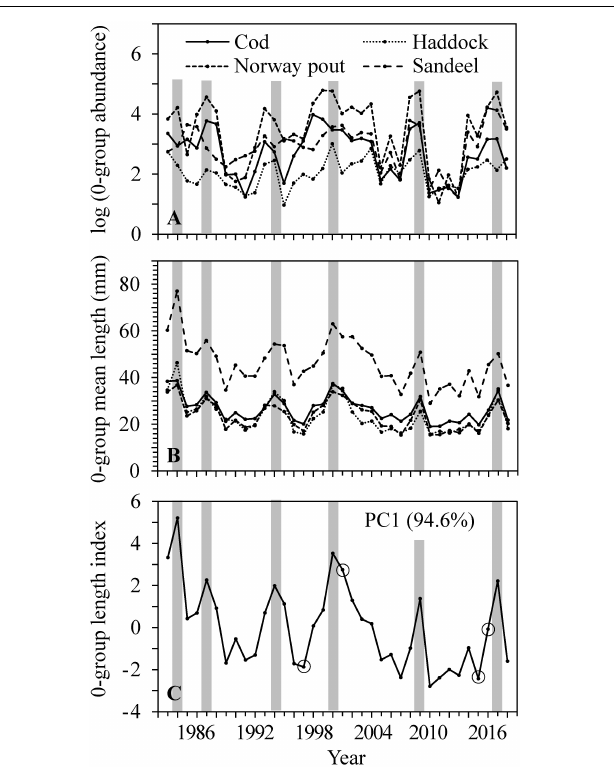
FIGURE 3 | 0-group cod, haddock, Norway pout and sandeel within the CS (i.e., average of all stations within the 100 m bottom depth contour) in 1983–2018. (A) Log of abundance and (B) mean length. (C) 0-group length index constructed from the factor scores of the first principal component (PC1) of the mean lengths. The PC1 explained 94.6% of the total inter-annual variability. Gray bars highlight peaks in abundance, mean length and 0-group length index, while open circles (O) indicate years where subsamples of cod were age analyzed.